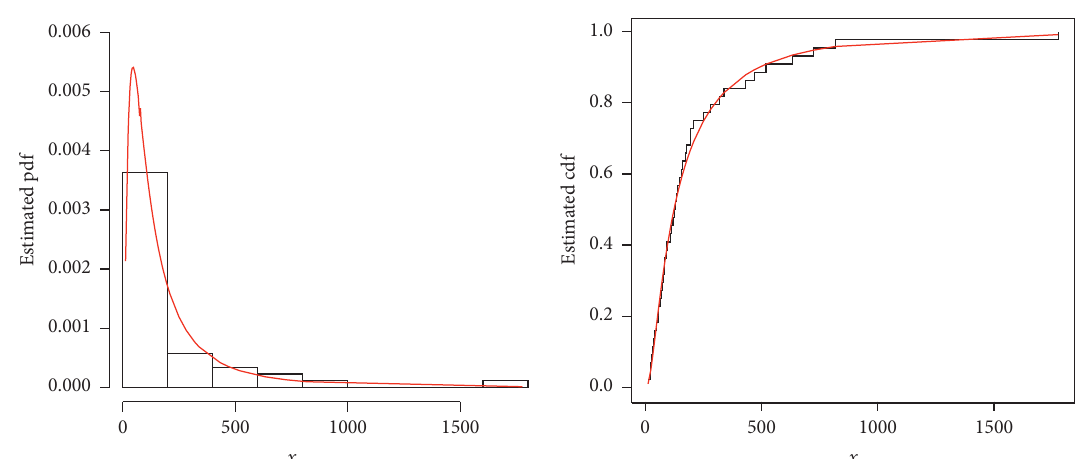
Figure 5: Plots for the estimated pdf and cdf of the NE-W distribution for data 2.